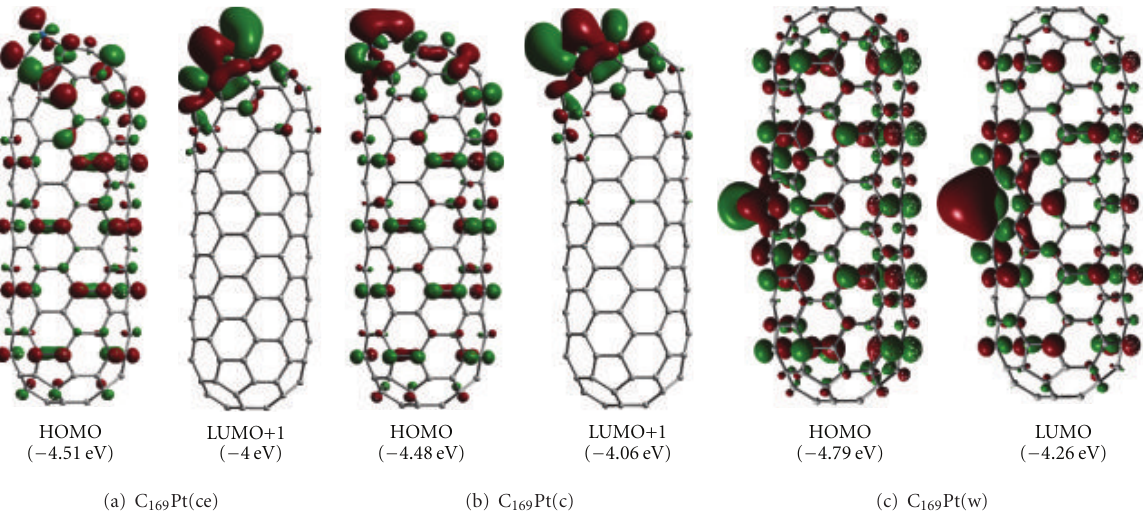
Figure 14: Relevant FMOs for C 169 Pt(ce), C 169 Pt(c), and C 169 Pt(w). Orbital energies are in parentheses [35, 36].